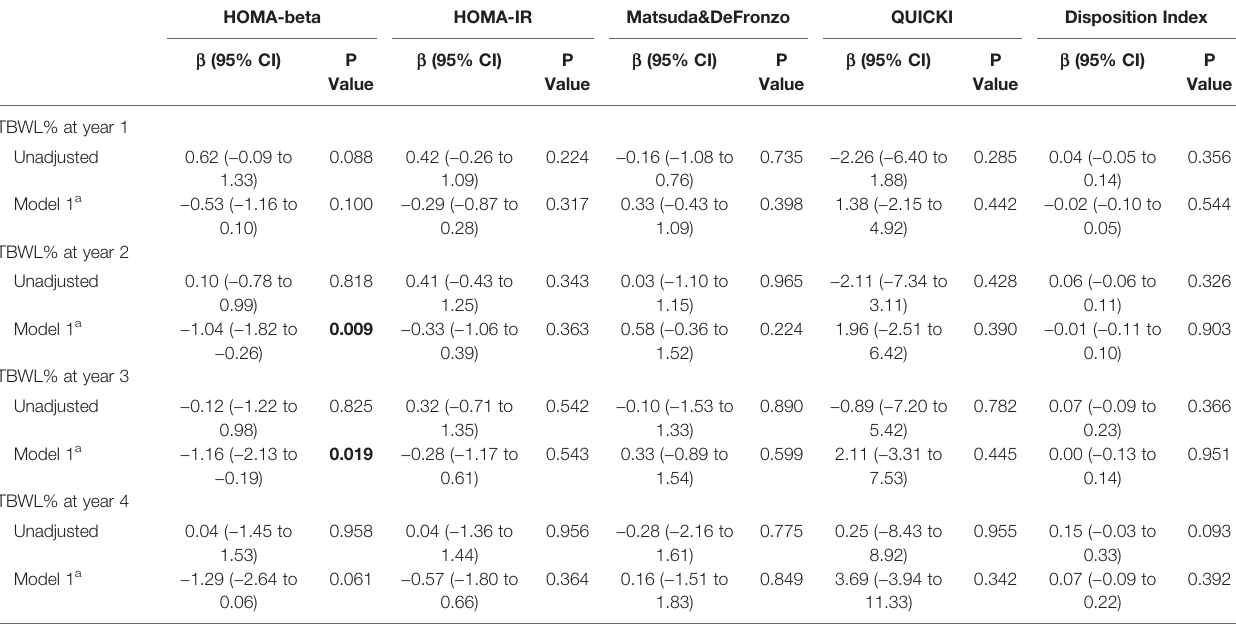
TABLE 2 | Associations between TBWL% and IR and beta cell function indexes at baseline. HOMA-beta HOMA-IR Matsuda&DeFronzo QUICKI Disposition